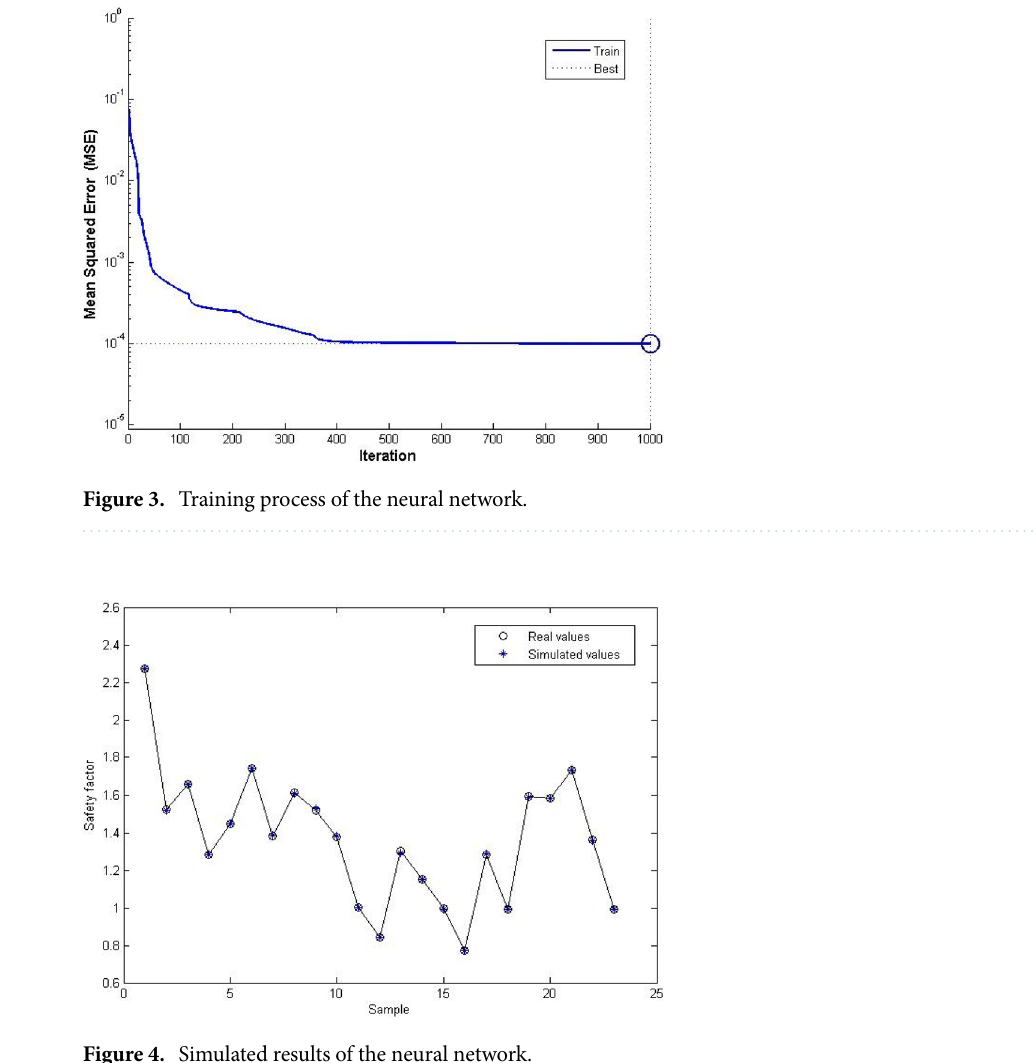
Figure 4. Simulated results of the neural